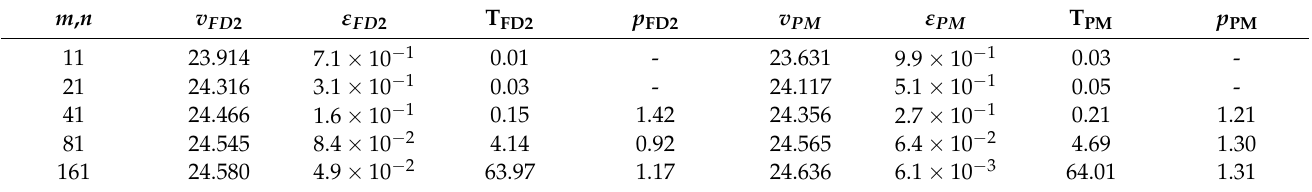
Table 3. Computational reports of fractional European put option pricing under Test Problem